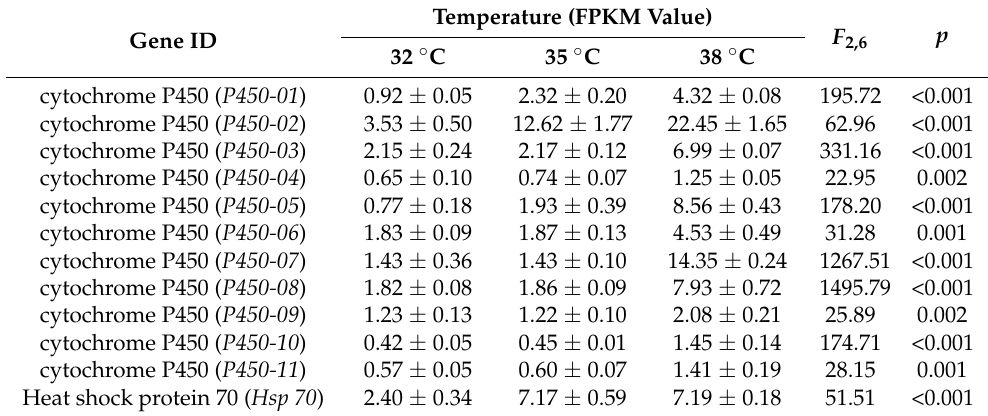
Table 4. Statistics of FPKM values of DEGs at different temperatures of P. quatuordecimpunctata . Gene